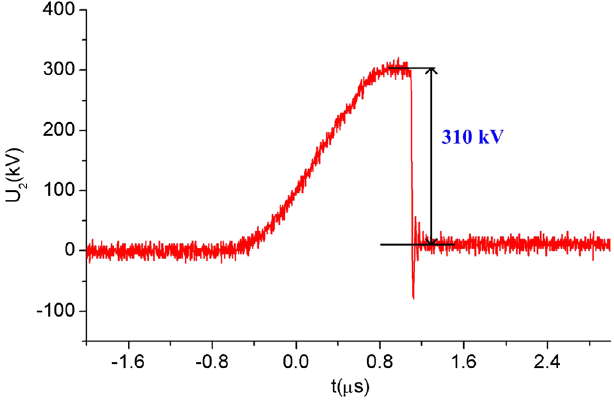
FIG. 8. Charging voltage waveform of load capacitor C 2 . the secondary circuit. The charging voltage waveform of C 2 is shown in Fig. 8. When initial charging voltage U 0 of C 1 is 1.9 kV, the peak charging voltage of C 2 is obtained as high as 310 kV and the step-up ratio is 1:163 . The peaking voltage time is 1 : 64 (cid:1) s [full width at half Maximum (FWHM) is 1 (cid:1) s ].